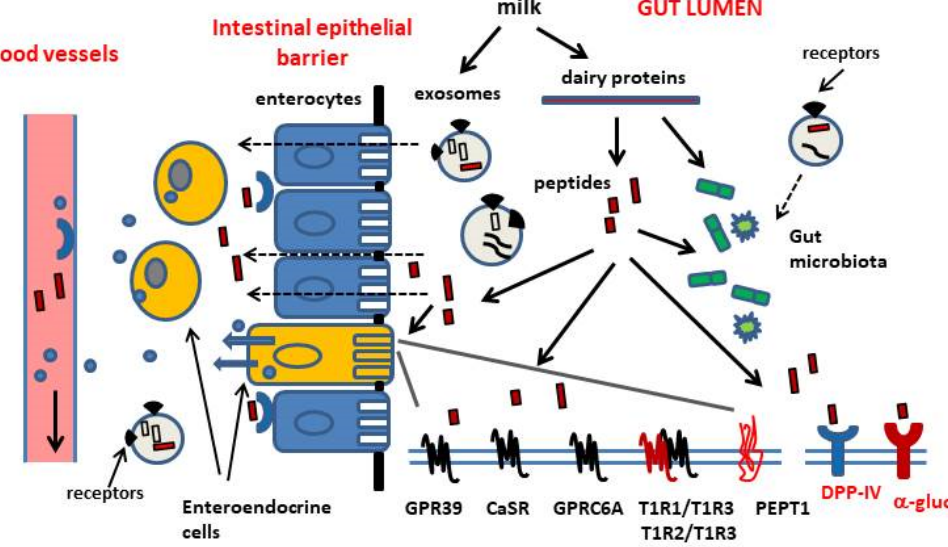
Figure 1. Schematic overview of some bioactive components that are released in the gastrointestinal tract upon intake and digestion of milk and dairy products, and their cellular and molecular targets at the level of the gut lumen and the gut wall. Digestion products of dairy proteins include free amino acids (not shown) and peptides. Some peptides act as signaling molecules and regulate the activity of enteroendocrine cells exposed to the gut lumen through binding to G-protein coupled